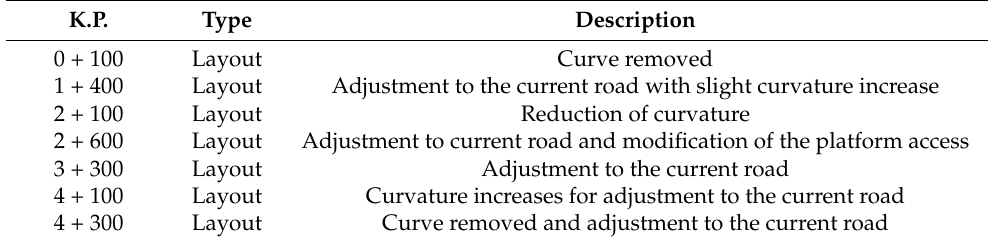
Table 1. Changes made to the road layout to generate the as-built model. K.P.